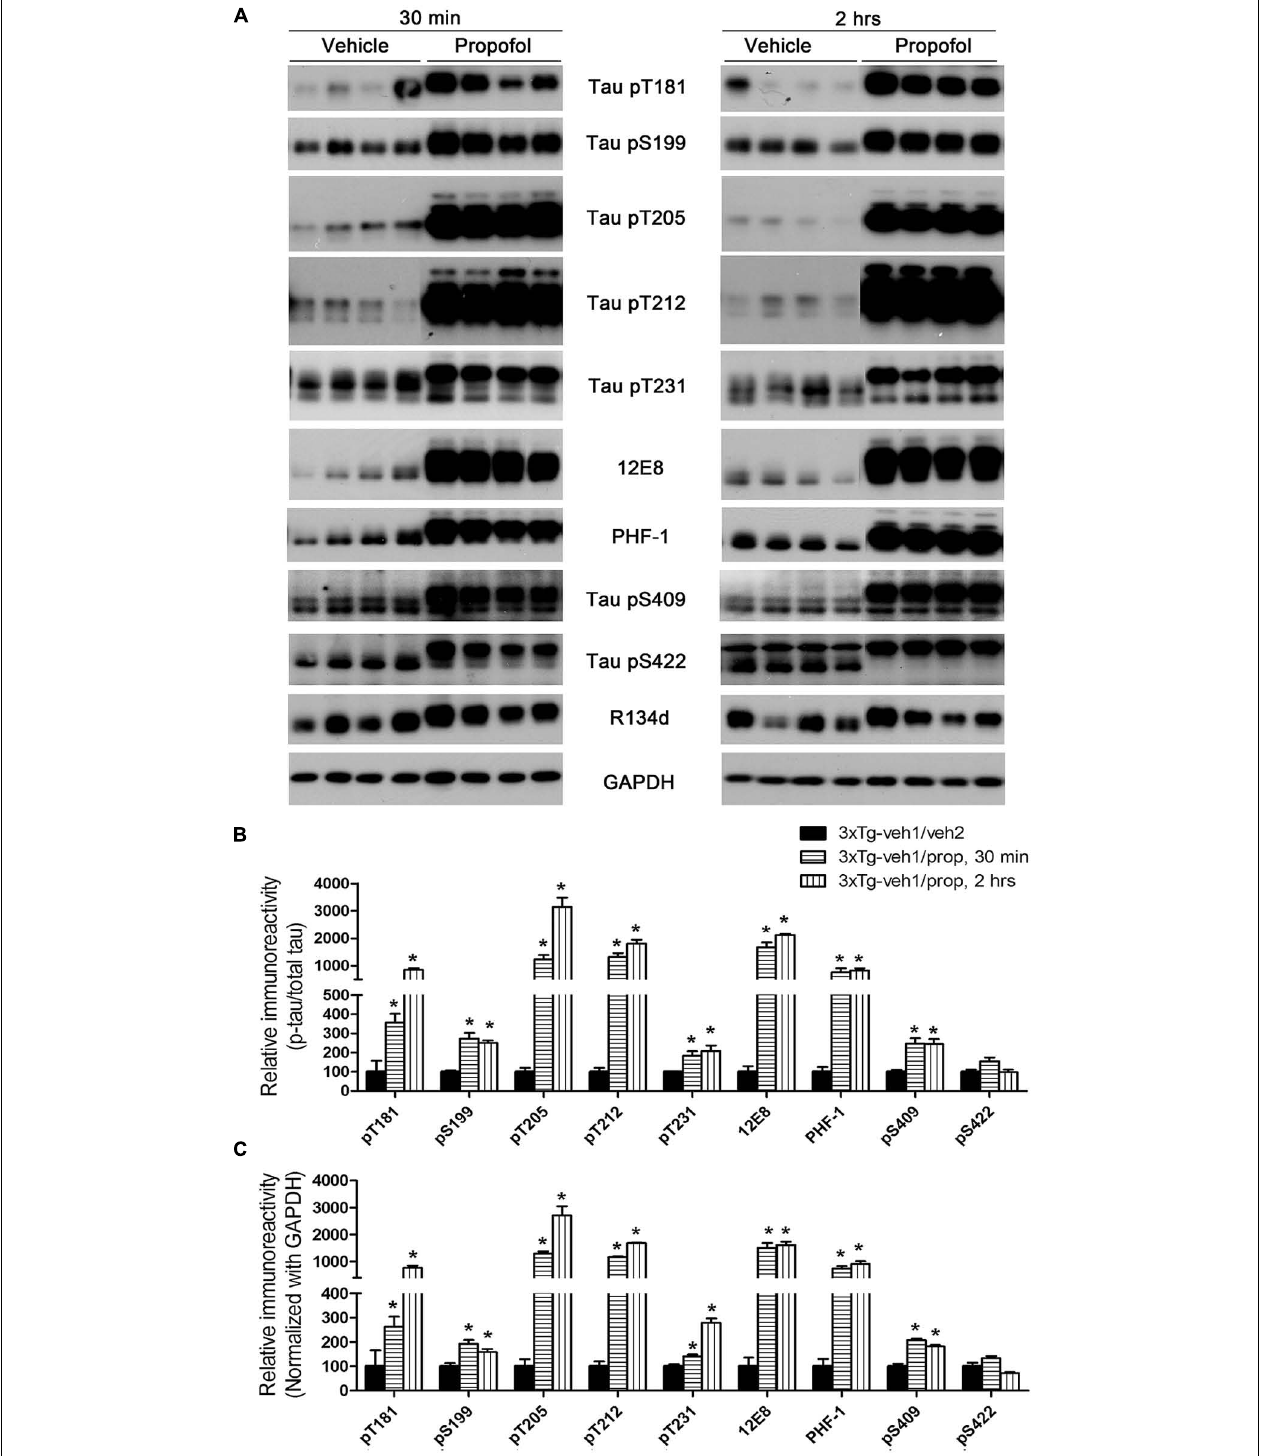
FIGURE 2 |Tau hyperphosphorylation at variousAD-related sites in the brains of 3xTg-AD mice after anesthesia with propofol. (A) Homogenates of the rostral halves of brains from 3xTg-AD mice sacrificed 30 min or 2 h following intraperitoneal injection of propofol were analyzed byWestern blots developed with antibody R134d against total tau and several